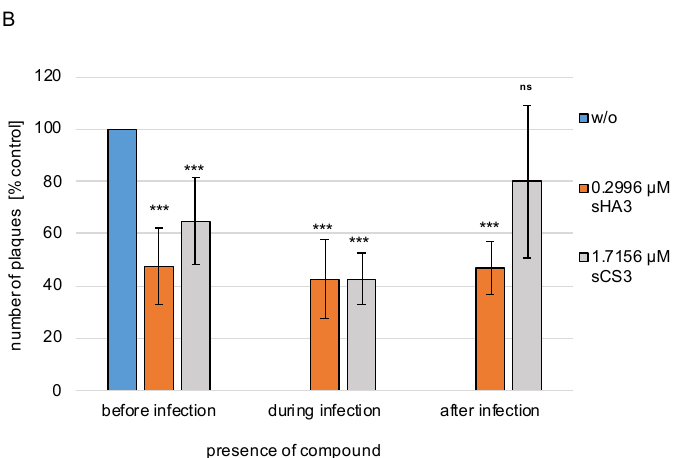
Figure 4. Effects of pre-, co- and post-treatment. ( A ) Diagram of the experimental settings. ( B ) PT cells treated with 0.2996 µM sHA3 or 1.7156 µM sCS3 before, during and after infection or left untreated ( w / o ) were subjected to plaque reduction assays. Shown are mean values and SD of three independent experiments. *** p < 0.001; ns, not significant.